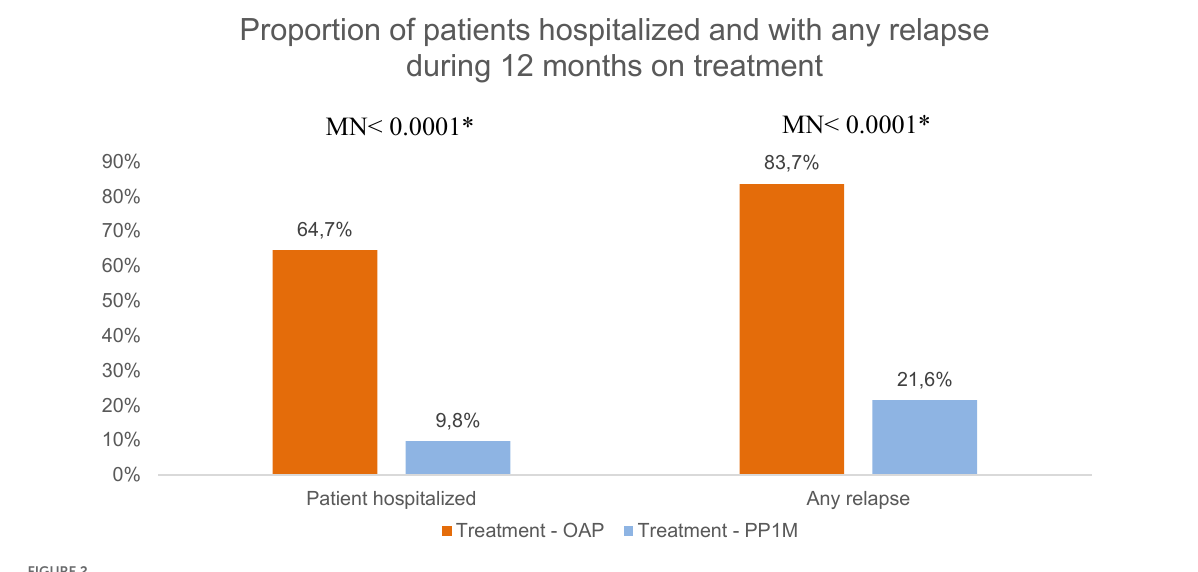
FIGURE2 Comparison between treatment conditions for the proportion of patients hospitalized and the occurrence of any relapse during 12 months of treatment. *McNemar test.